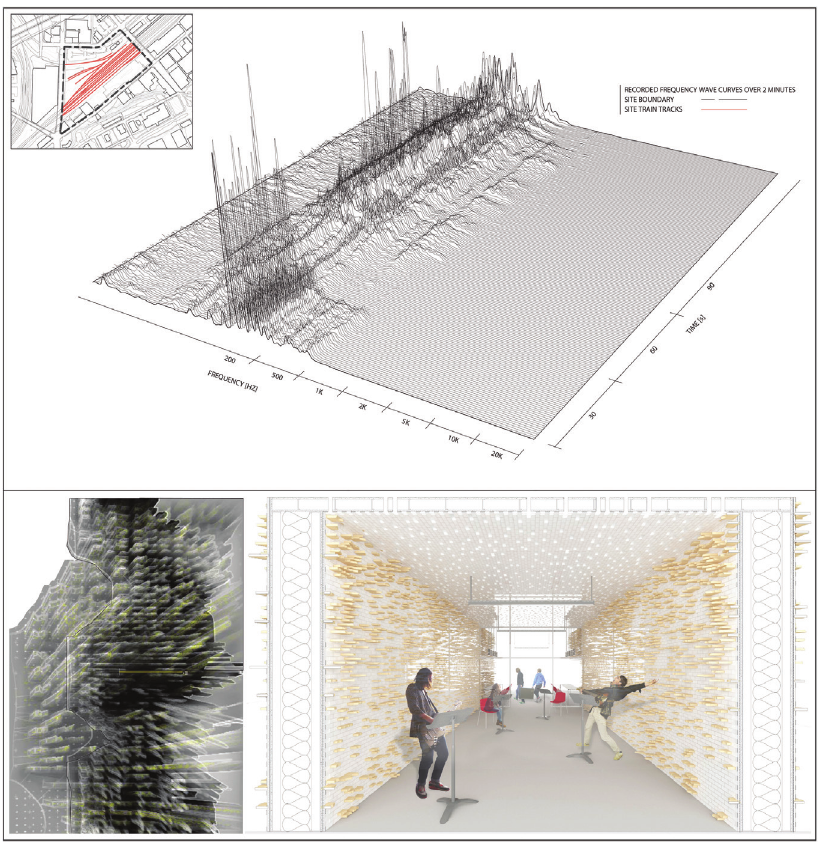
Figure 6: Top: work by a graduate landscape architecture student that focused on using visual coding platforms to define and analyze soniferous site properties. Bottom: student work by 3rd year interior architecture student. The design of an acoustical interior topography utilizing the same sound visualization script developed by Graduate Landscape Architecture student in left image. (Upper images by Paul Bamson, University of Tennessee Graduate Student, 2017. Lower images by Heather Shine, University of Tennessee Undergraduate Student,